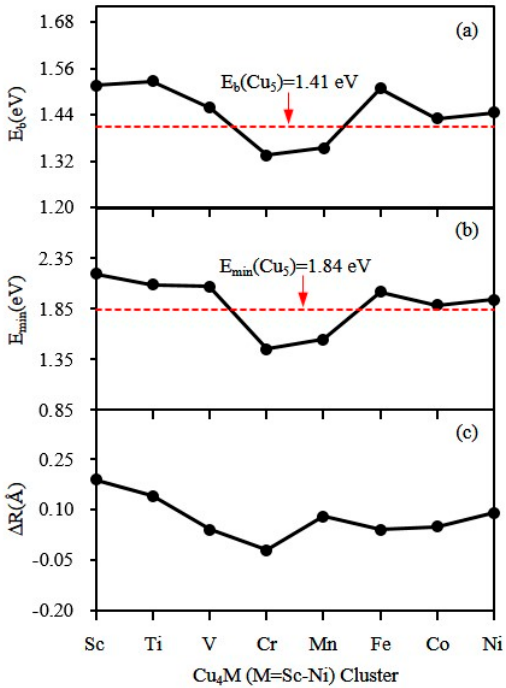
Figure 3. The atomic averaged binding energy ( a ), the minimum DE ( b ) and the overlap of orbital radius for the ground-state Cu 4 M (M = Sc-Cu) clusters ( c ). Table 4. The dissociation energy (DE) of Cu 5 and Cu 4 M (M = Sc-Ni) clusters for the distinct dissociation channels.